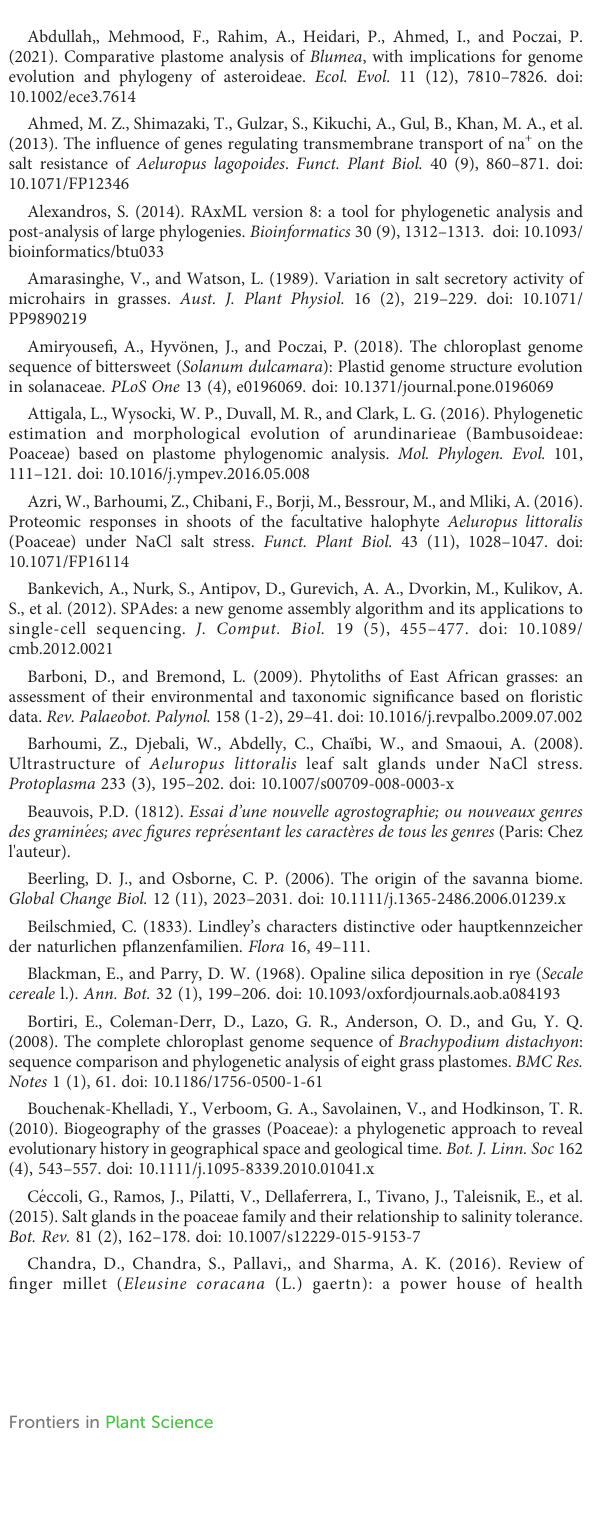
SUPPLEMENTARY FIGURE 5 Stomatal subsidiary cell shape found in Chloridoideae. (A) fl at-top type, (B) peaked type, (C) low-domed type. Red scale bars: 20 m m. SUPPLEMENTARY FIGURE 6 Microhair type found in Chloridoideae. (A) enneapogonoid type, (B) long- base cell microhair with sharp-cap cell, (C) long-base cell microhair with round-cap cell, (D) long-base cell microhair with non-constricted base, (E) narrow equal-base-cell microhair, (F) well-proportioned equal-base-